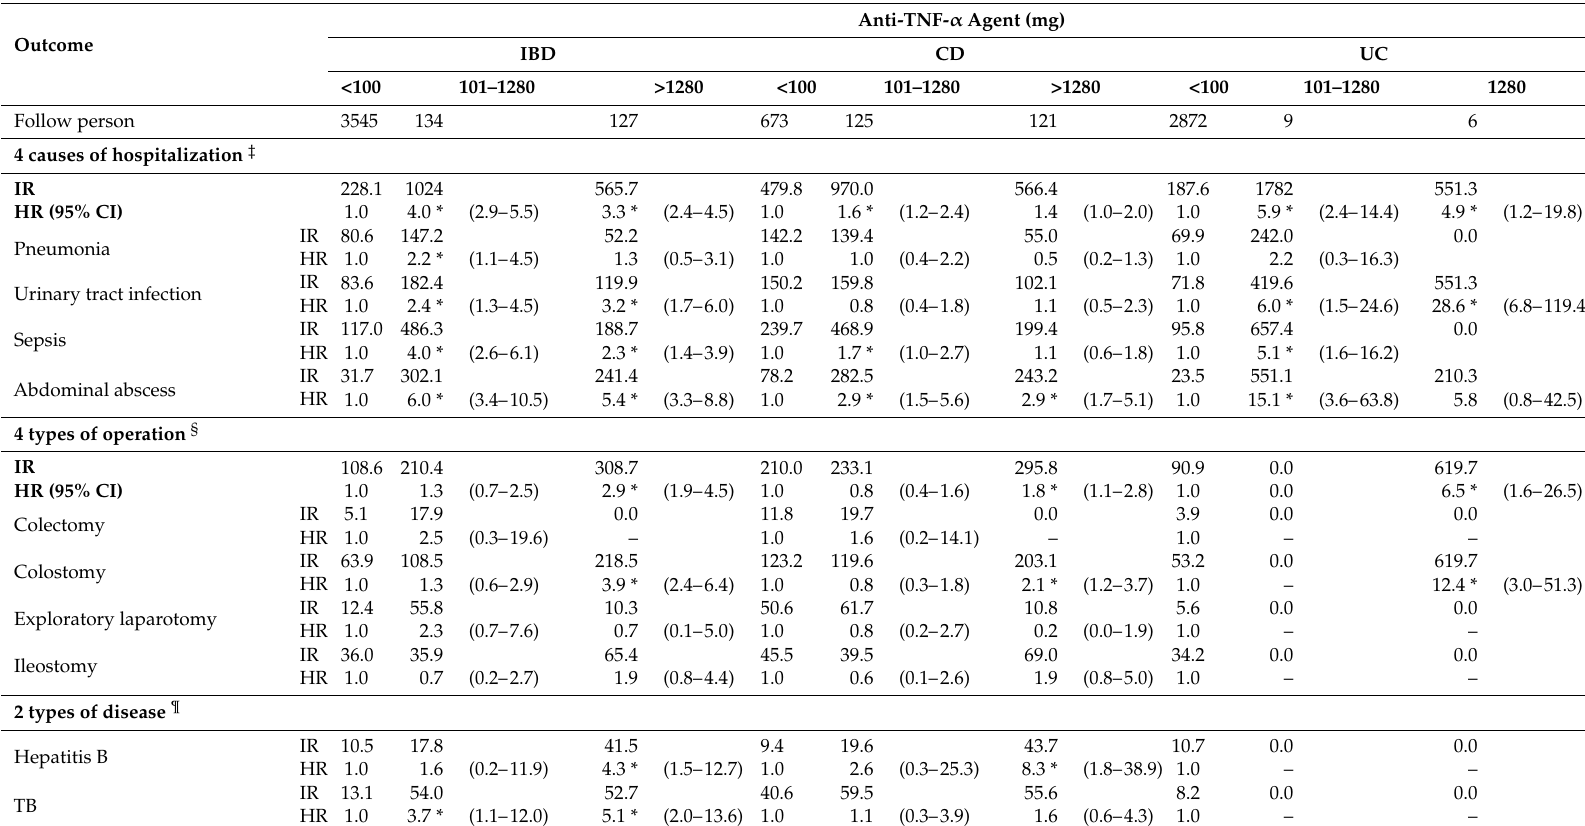
Table 4. Risks of operation, hospitalization, and related diseases associated with anti-TNF- α therapy among patients with IBD in Taiwan, 2001–2015.